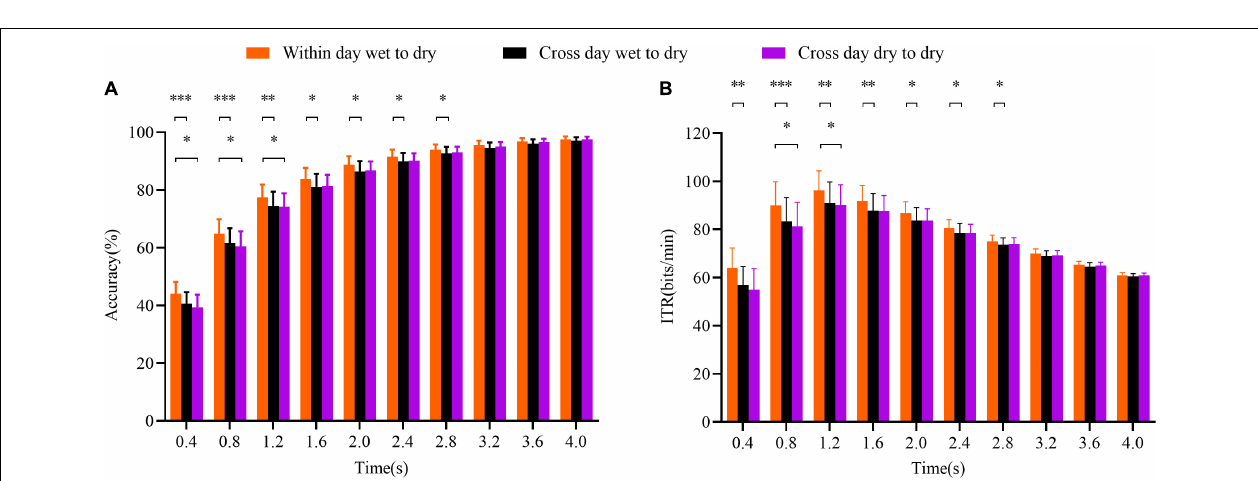
FIGURE 5 | Comparison of the accuracy and ITR results of the five methods in the cross-day wet-to-wet transfer experiment. (A) Accuracy. (B) ITR value. The horizontal axis represents the data length; the error bars indicate standard errors.